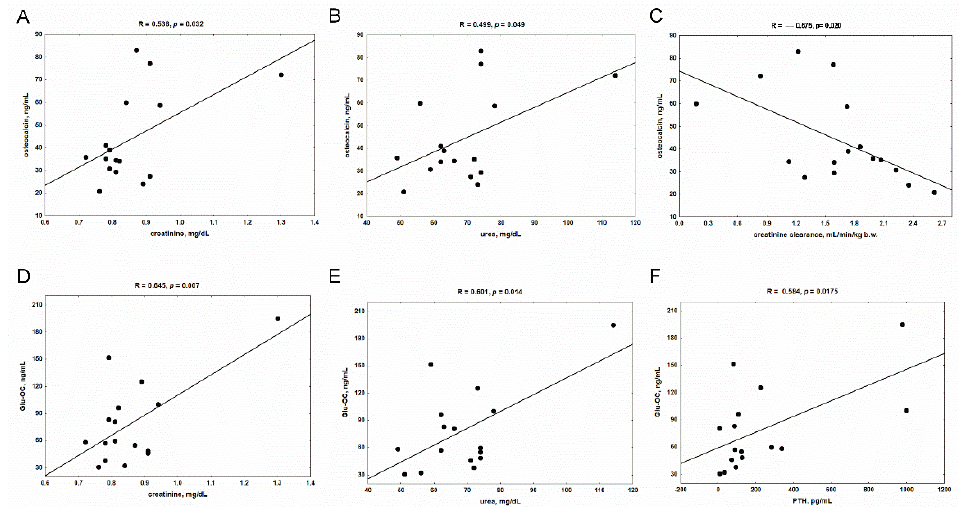
Figure 3. The associations between serum levels of osteocalcin and its undercarboxylated form (Glu‐OC), and markers of kidney function: creatinine (A, D), urea (B, E), creatinine clearance (C) and parathyroid hormone (PTH) concentration (F) in rats with chronic kidney disease (CKD).